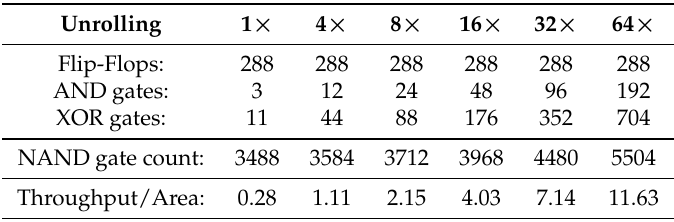
Table 13. Theoretical Prediction of the Effect of Unrolling on Trivium